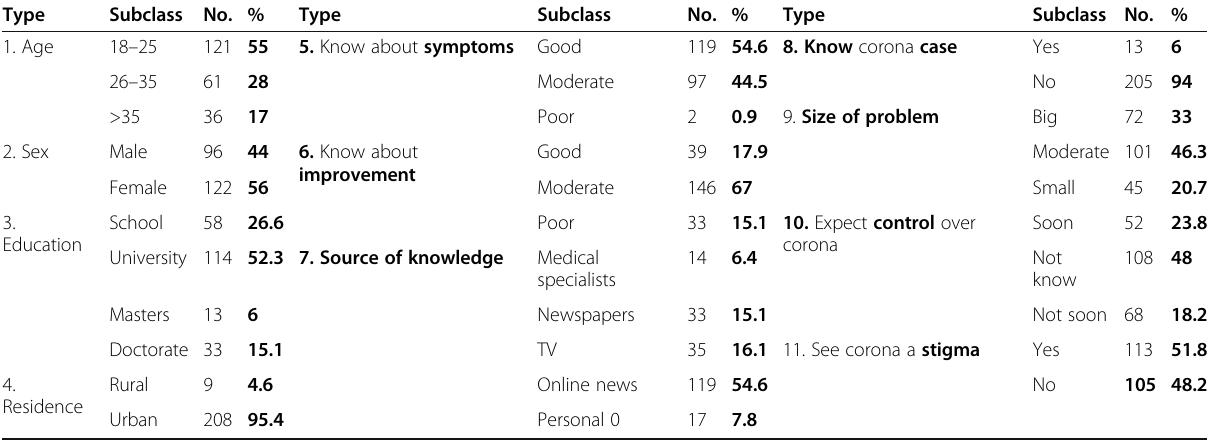
Table 1 Socio-demographics, knowledge, and stigma among studied subjects ( n = 218)